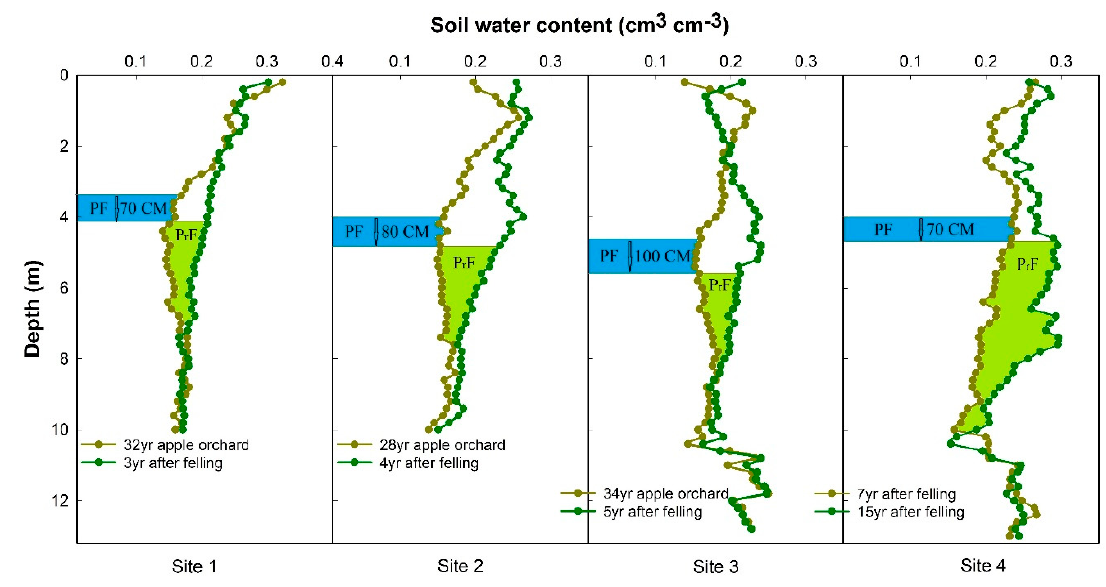
Figure 5. Soil water content, PF and P r F.